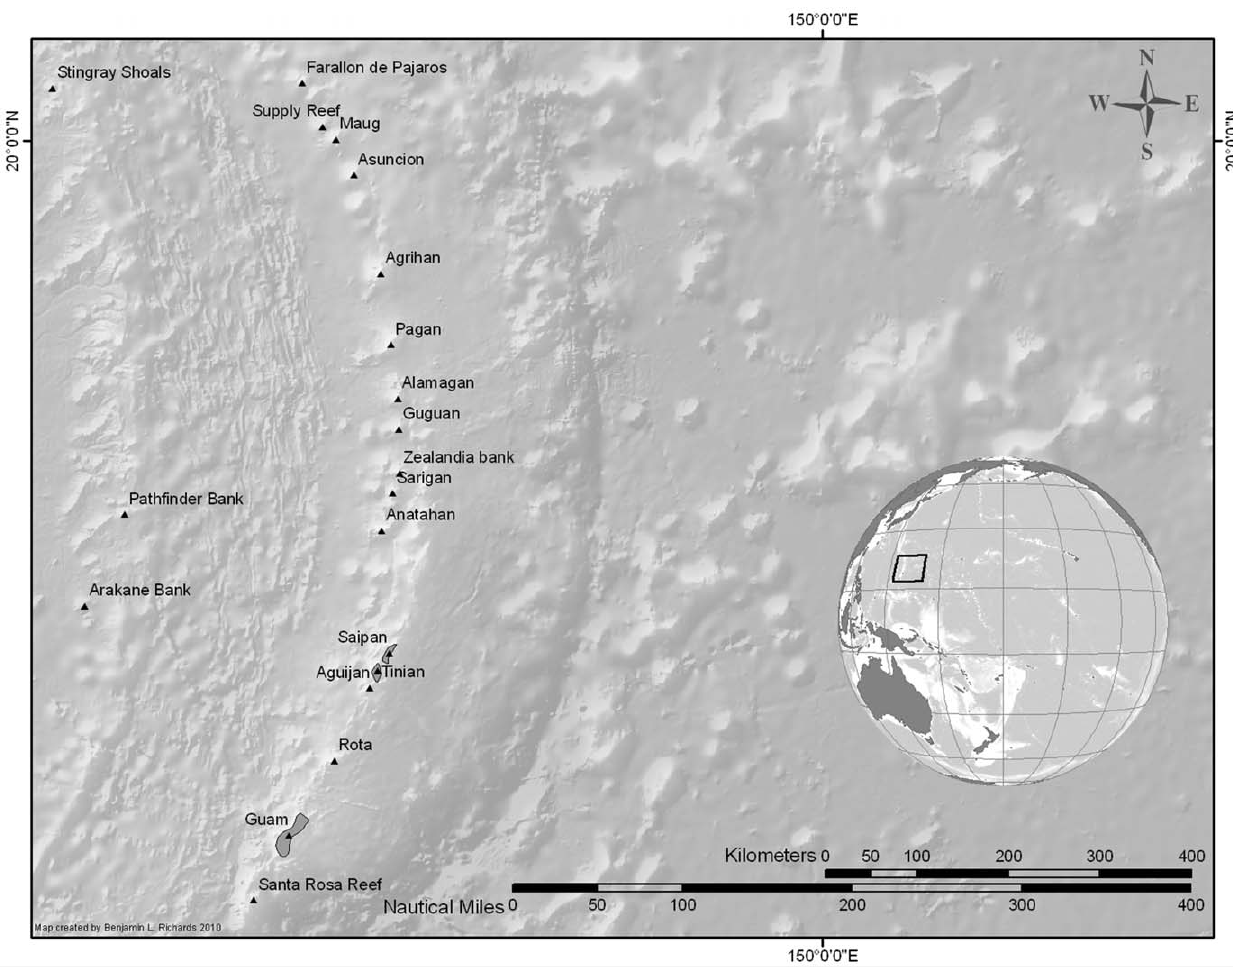
Figure 1. Study area, The Mariana Archipelago showing the location of all islands and banks.